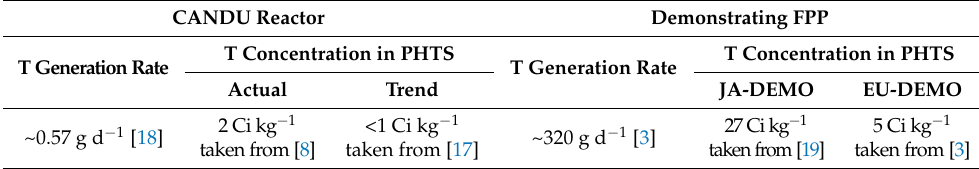
Table 1. Tritium concentration values in